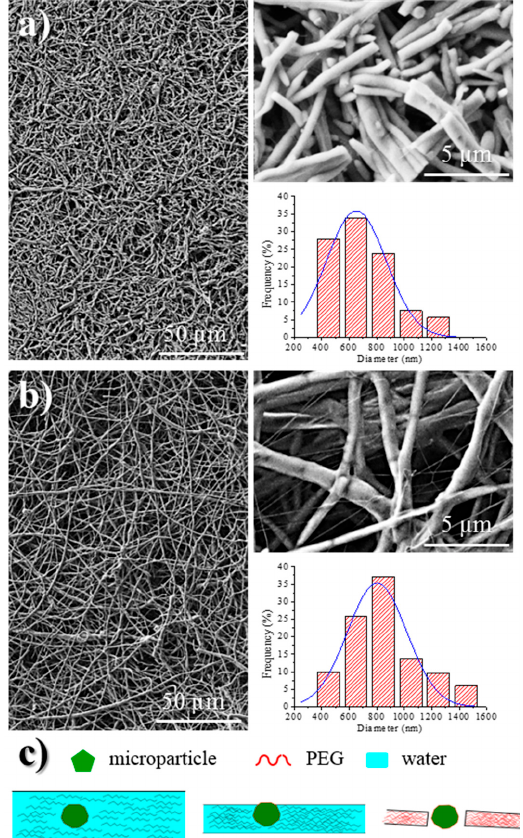
Figure 6. SEM micrographs showing electrospun PEG fibers obtained from F ( a ) and W ( b ) solutions using the optimized processing parameters for each solvent. Insets showed the corresponding diameter distributions and a magnification of micrographs. ( c ) Proposed mechanism for explaining the fiber breakage trend for scaffolds prepared from F solutions.